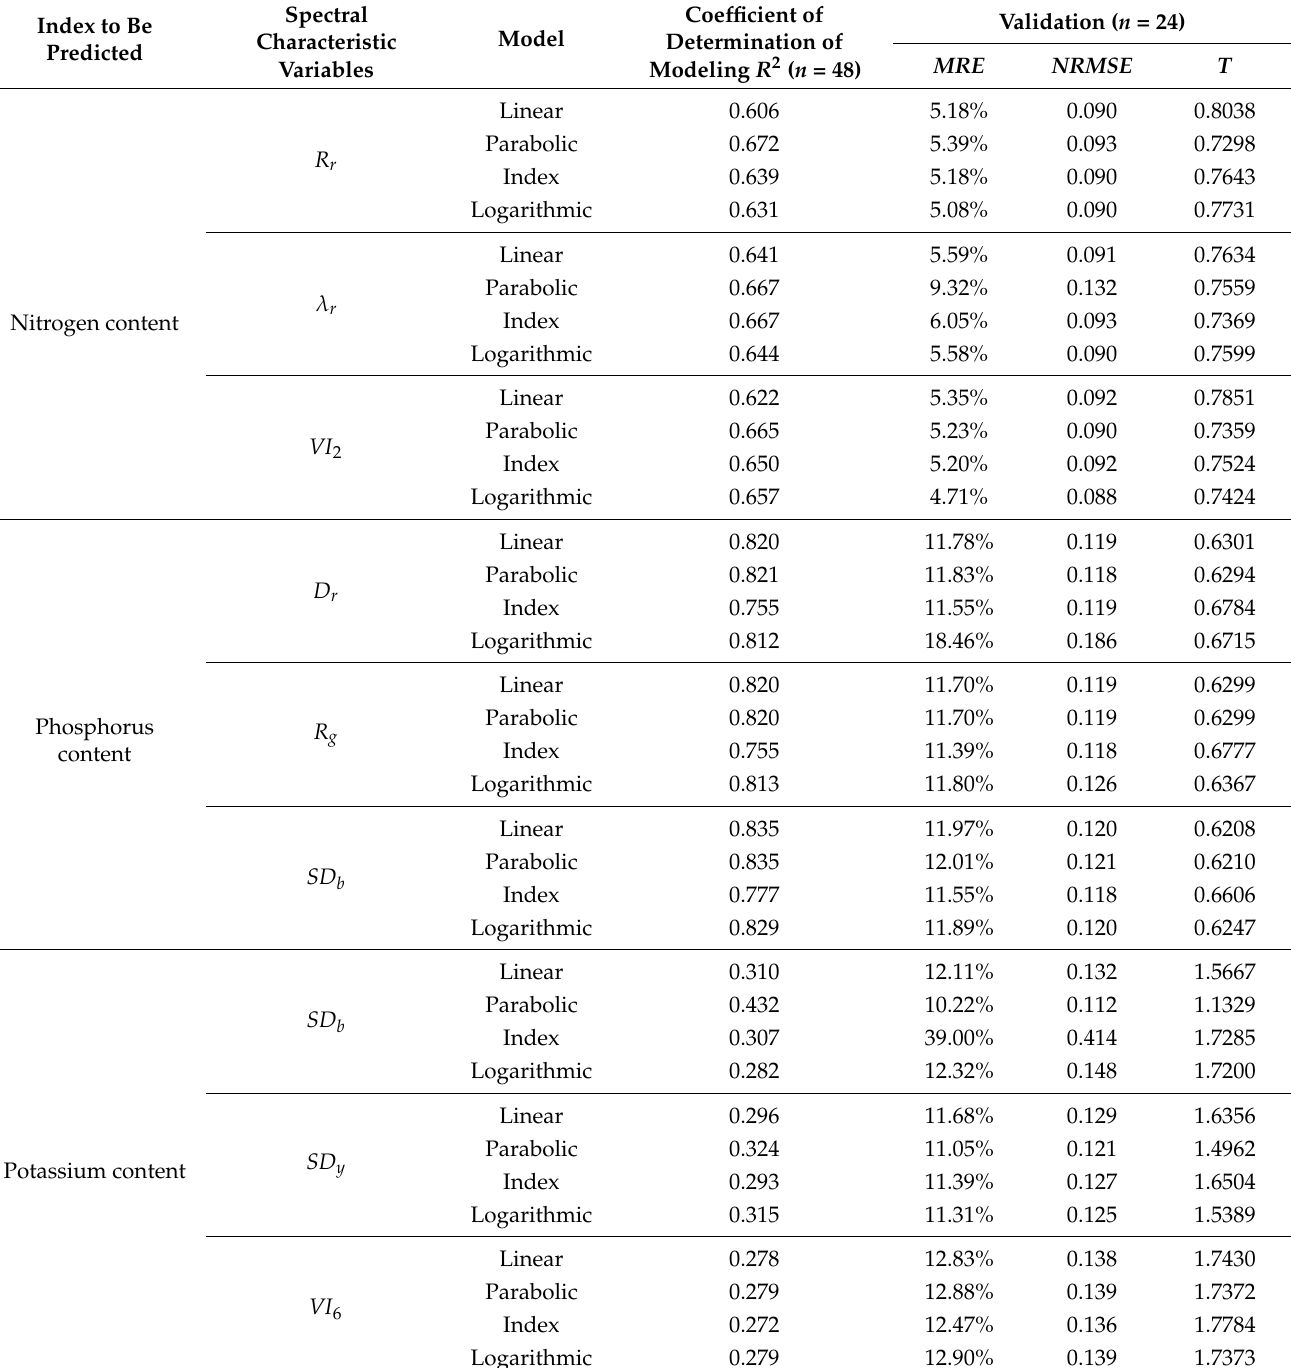
Table 3. Results of nitrogen, phosphorus and potassium content diagnostic